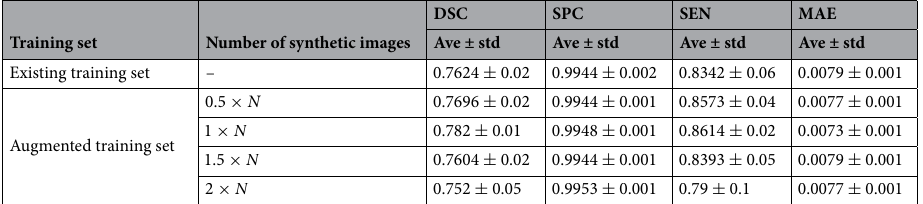
Table 6. Evaluation of the proposed data augmentation method’s efficacy through a two-step 10-fold cross- validation approach.